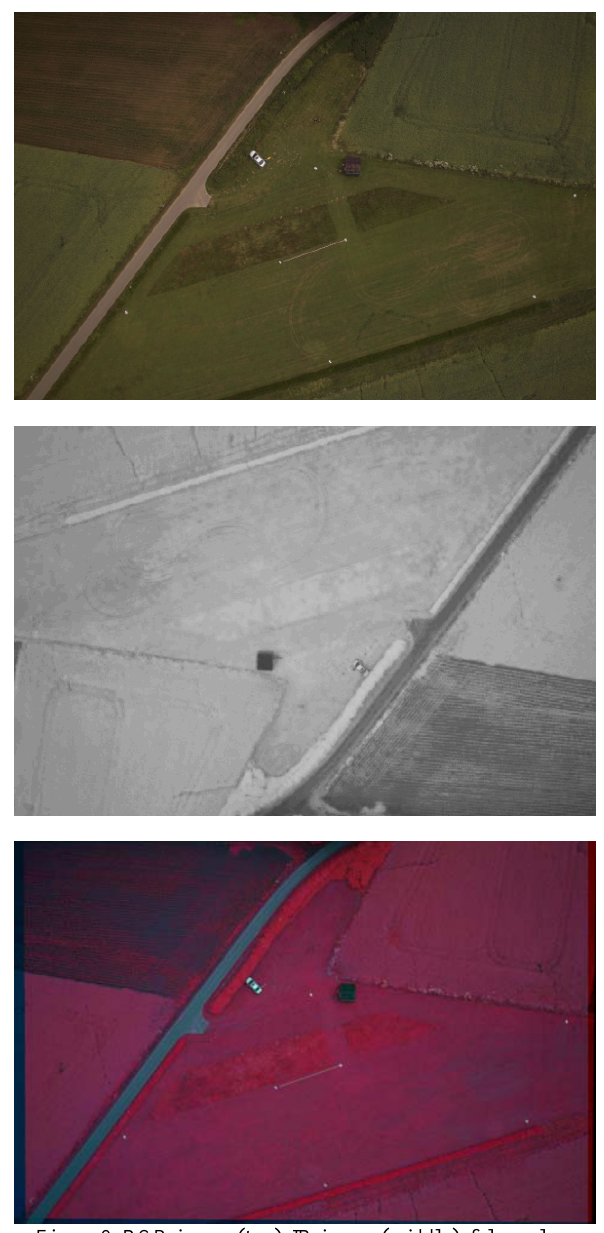
Figure 9. RGB image (top), IR image (middle), false colour image with green, red, infrared channel